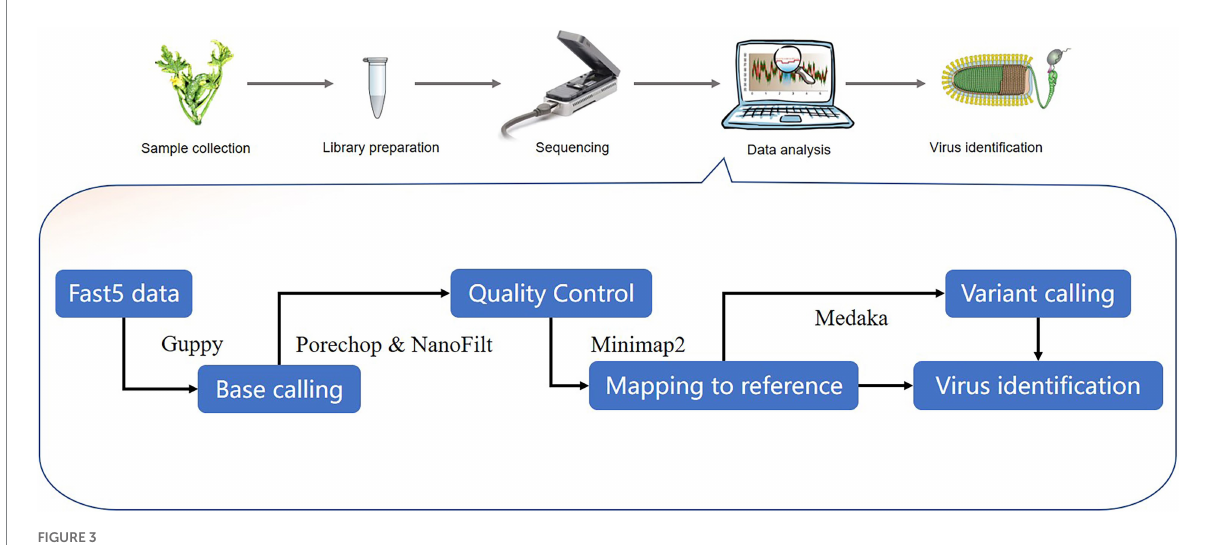
FIGURE 3 Outline of potential stages in the workflow for nanopore-seq analysis for plant virus detection. Representative bioinformatics tools are shown in the